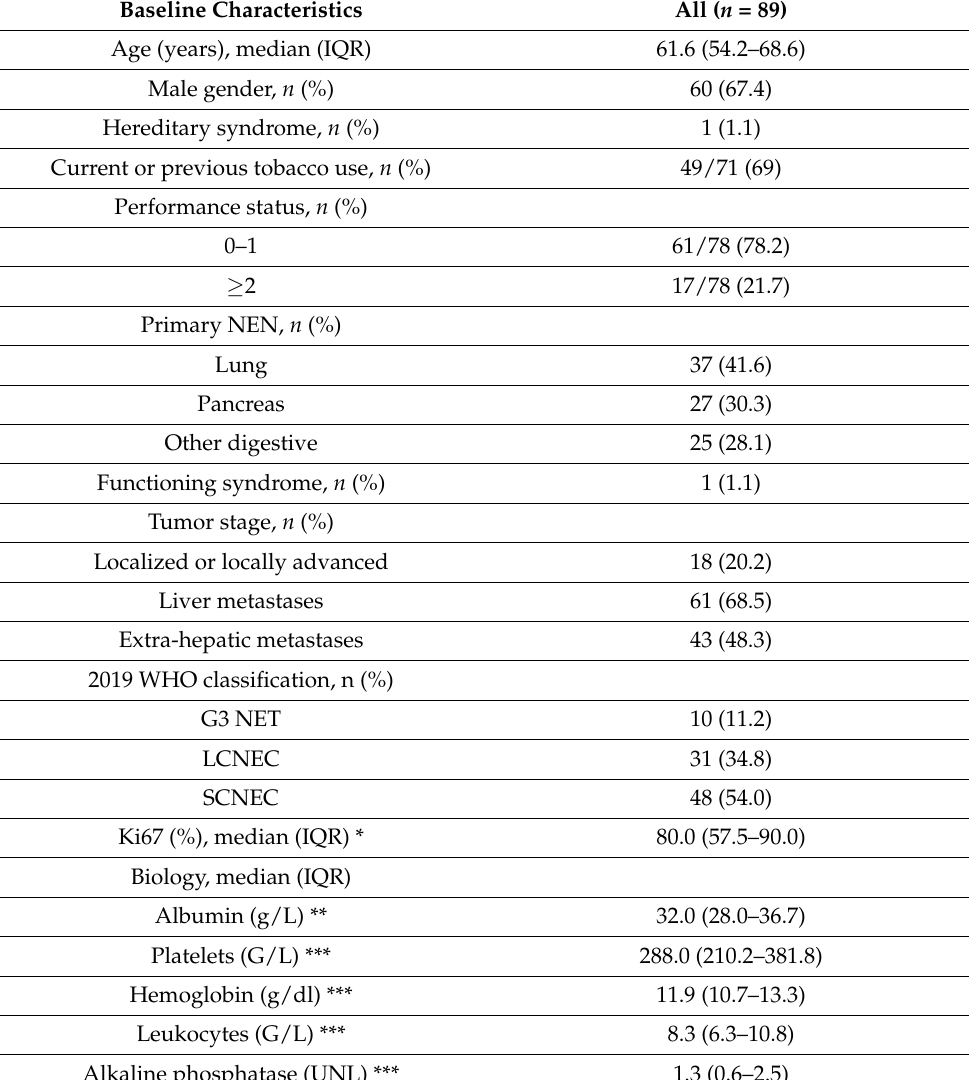
Table 1. Characteristics of 89 patients with grade 3 neuroendocrine neoplasms (G3 NEN) treated with etoposide-platinum (EP)